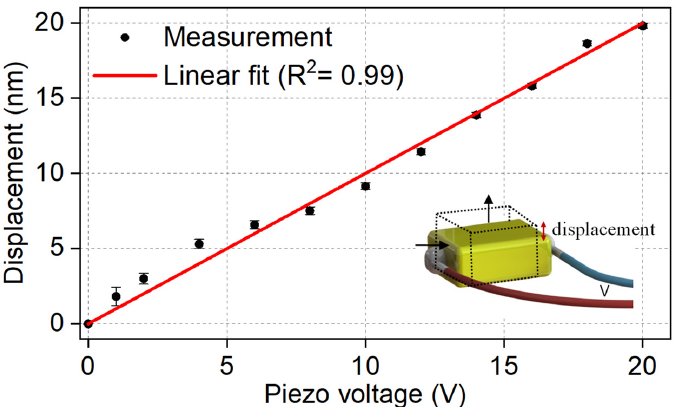
Figure 2. Measured displacement value of the piezo transducer at different voltage values. The inset shows the longitudinal displacement of the piezo when voltage is applied.